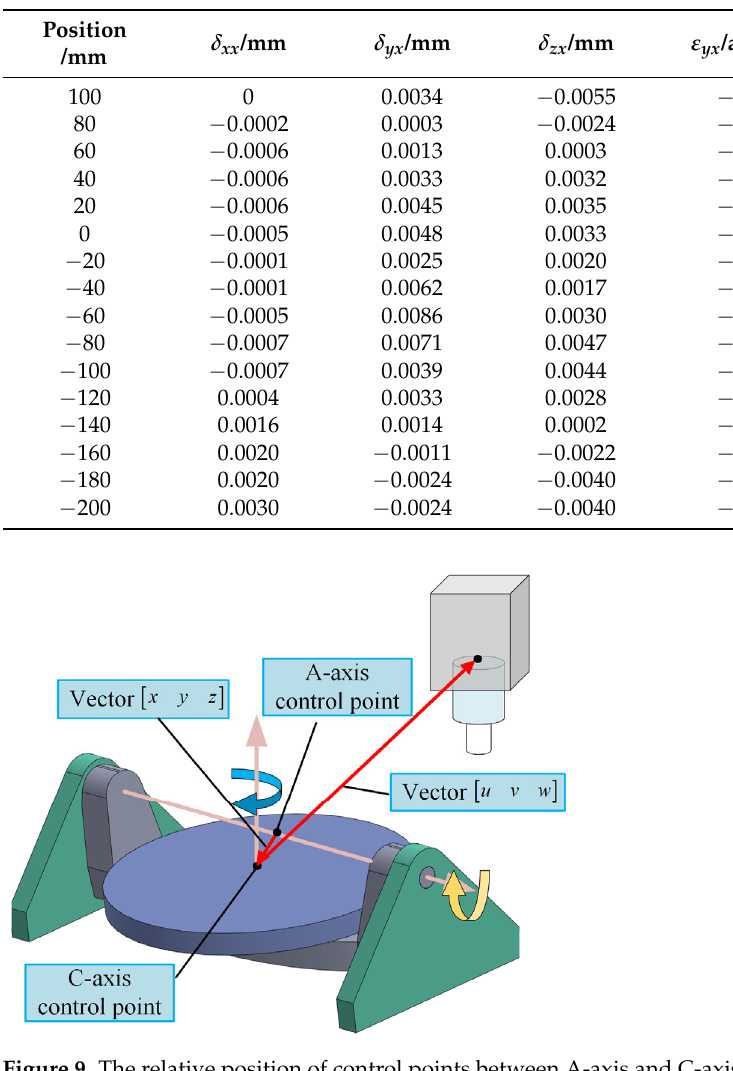
Table 2. The PDGEs of X-axis.